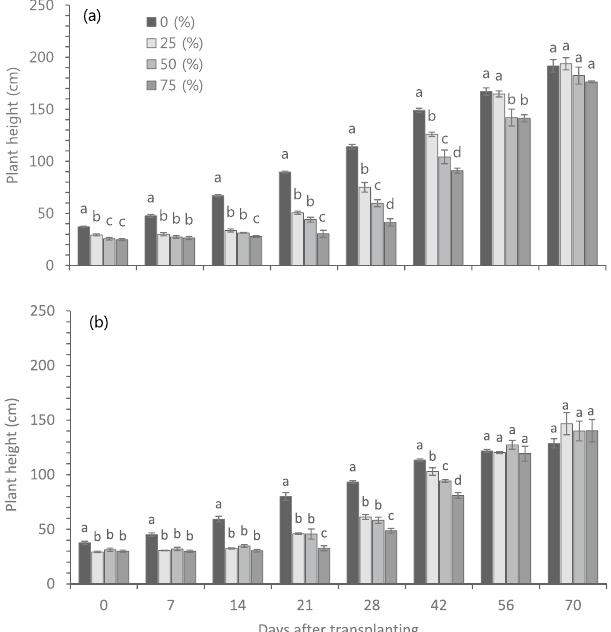
Figure 5. Effect of different leaf heat damage levels on plants growth rate in hot pepper cultivars susceptible ( a , ‘Chyung Yang’) and tolerant ( b , ‘NW Bigarim’) to heat stress. Vertical bars represent standard deviation (n = 3). Different letters indicate significant differences by Duncan’s multiple range test at p < 0.05.